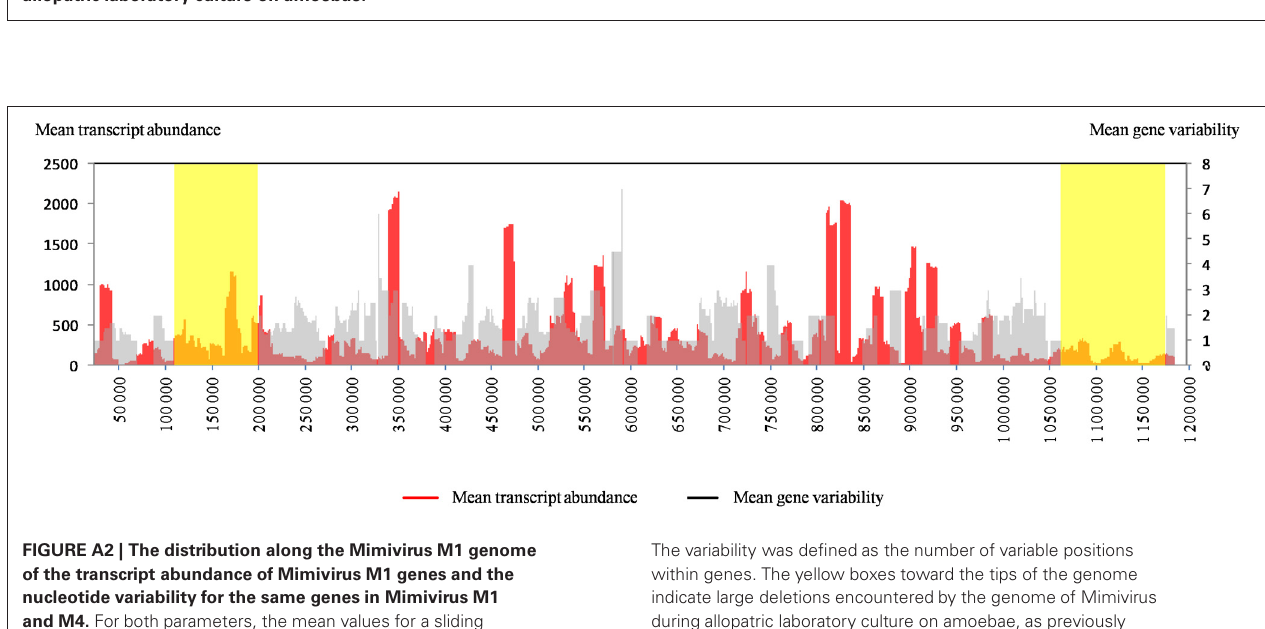
The variability was defined as the number of variable positions within genes. The yellow boxes toward the tips of the genome indicate large deletions encountered by the genome of Mimivirus during allopatric laboratory culture on amoebae, as previously reported (Boyer et al.,